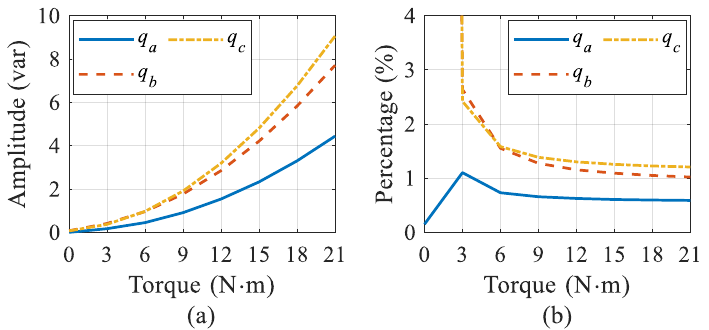
Figure 6. The amplitudes of the second harmonics in IRPs ( a ) and the proposed indicators ( b ), with ITSC, at different torques. ω m was fixed at 100 r/min.